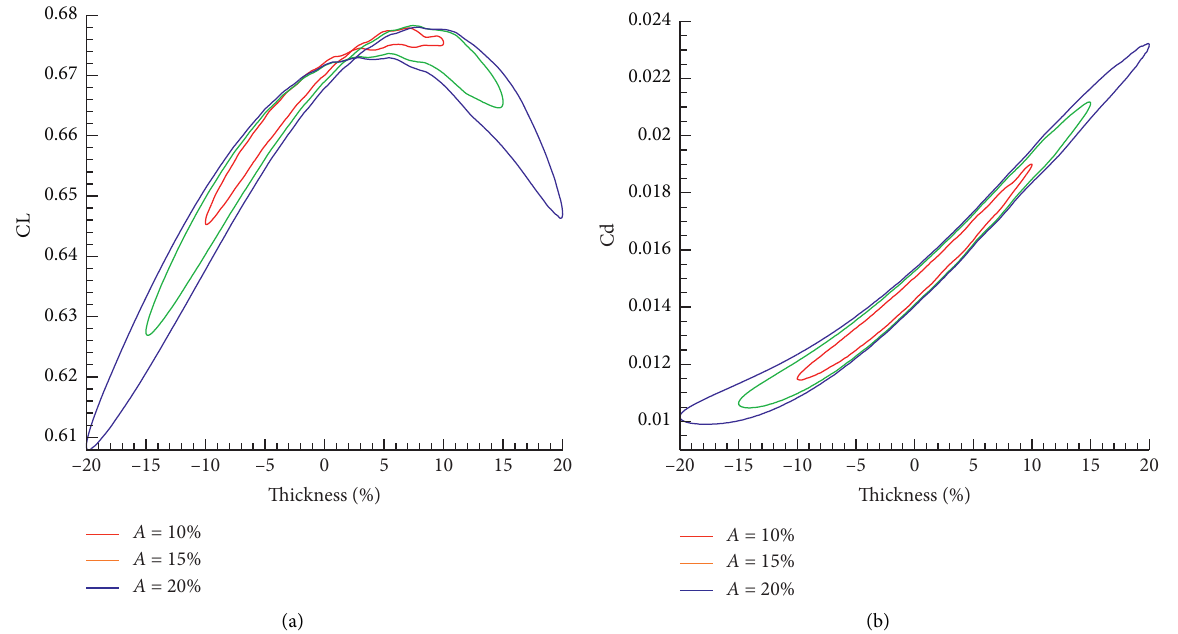
Figure 9: Influence of thickness deformation amplitude on aerodynamics ( M � 0.74, α � 2 ° , and f � 1HZ, CFD).